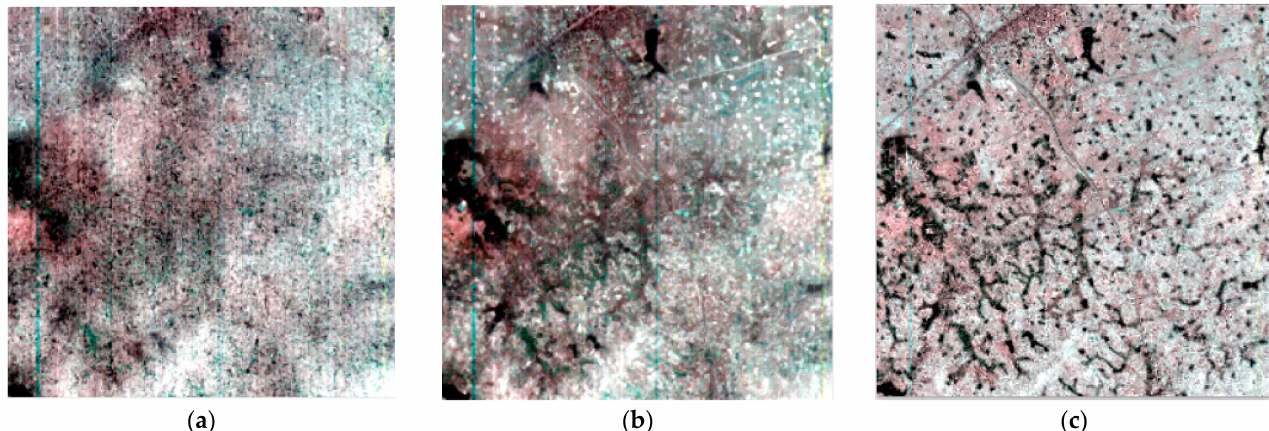
Figure 23. Different mode of up-sampling for the Chaohu dataset. ( a ) Nearest ( b ) bilinear ( c ) bicubic.